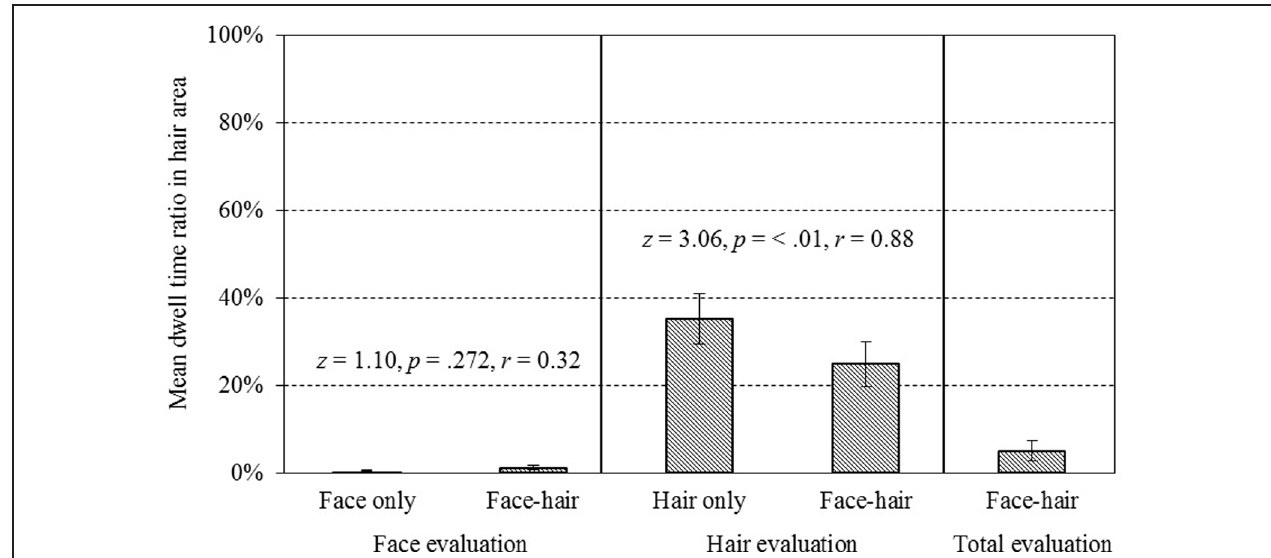
FIGURE 4 | The dwell time ratio of eye gaze within the hair area while performing each task (DwR H ). A Friedman’s rank test showed a significant main effect of conditions [ χ 2 (4) = 39.9, p < 0.001]. DwR H in hair attractiveness evaluation for face–hair composites was significantly lower than